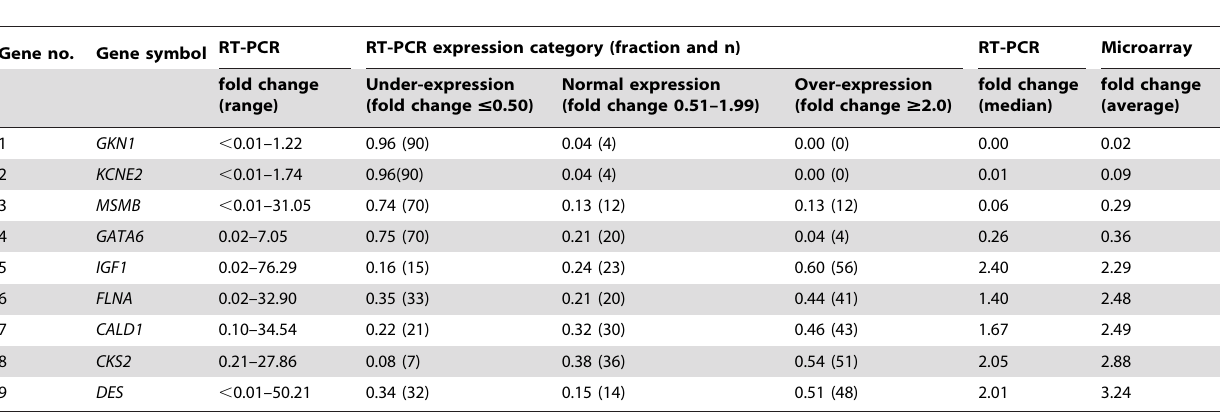
Table 5. Gastric noncardia adenocarcinoma tumor/normal RNA expression fold change for genes validated by RT-PCR and comparison with microarray results (n=94 cases, 9 genes).